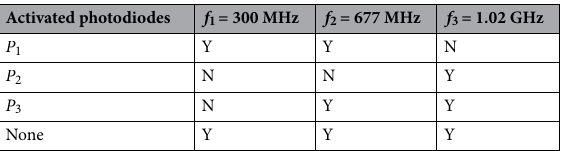
Table 3. Relationship between activated photodiodes and three reconfigurable working frequencies.